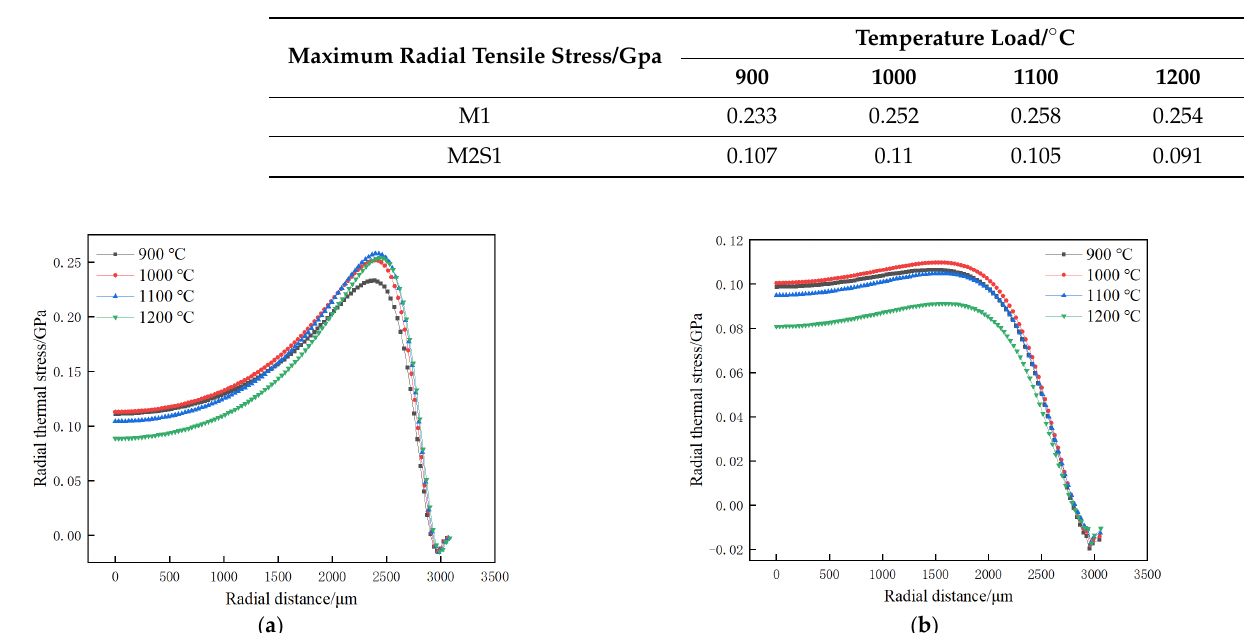
Figure 5. Comparison of radial thermal stress distribution on the surface of LMA layer of ( a ) M1 and ( b ) M2S1 specimens at four operating temperatures. Table 5. Maximum radial thermal stress value of the LMA layer surface of the M1 and M2S1 speci- mens at the four operating temperatures.